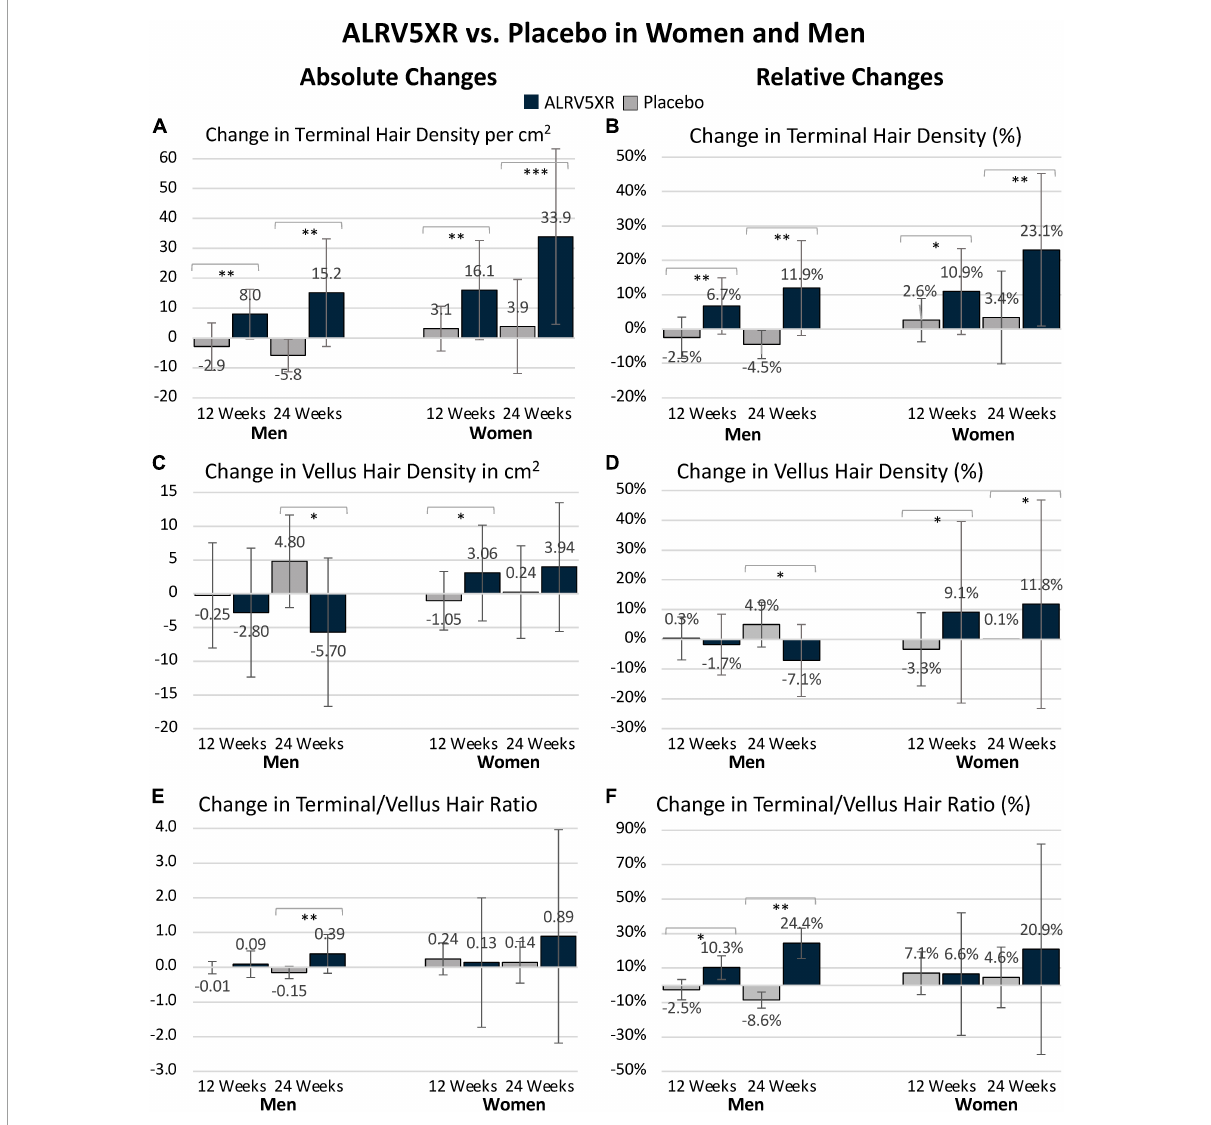
FIGURE1 ALRV5XR vs. Placebo in women and men with AGA and TE over 24 weeks. (A) Absolute Changes (AC) in Terminal Hairs (TH) per cm 2 ; (B) Relative Changes (RC) in TH in percent (%); (C) AC in Vellus Hair (VH); (D) RC in VH%; (E) AC in TV/VH ratio; (F) RC in TH/VH ratio in %. Statistical significance of ALRV5XR vs. Placebo: ∗ P < 0.05, ∗∗ P < 0.01, and ∗∗∗ P < 0.001. Error bars are 95% confidence